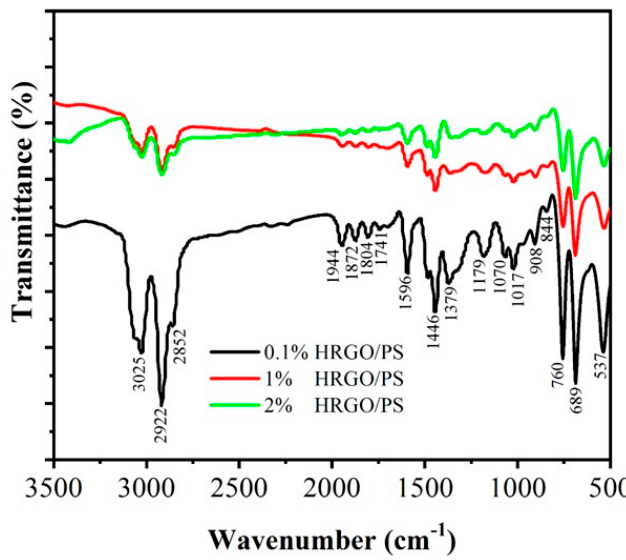
Figure 1. Fourier transform infrared (FTIR) spectra of 0.1% holey reduced graphene oxide/polystyrene